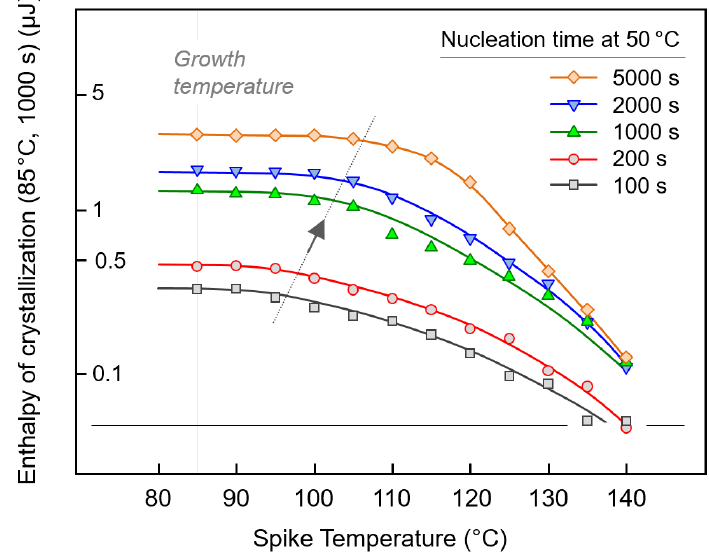
Figure 4. Enthalpy of the crystallization of PBI at 85 °C for 1000 s as a function of the spike temperature on the transfer of nuclei from the nucleation stage to the growth stage (see also left plot in Figure 3). Samples were subjected to nucleation at 50 °C for different times, as indicated in the legend, and the nuclei-transfer heating rate was 1000 K/s. The lines connecting the symbols serve to guide the eye only. The gray line with the arrow emphasizes that the nuclei size distribution changes with the nucleation time such that generation of an increased fraction of larger nuclei shifts the downturn in the curves to higher spike temperatures (see) with increasing nucleation time.